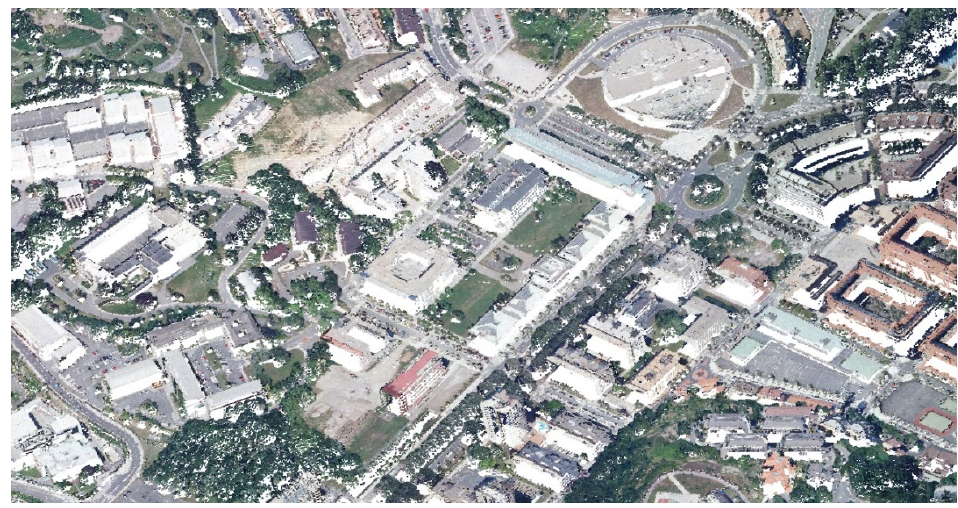
Figure 5. 2012 flight LiDAR point cloud of the UPV/EHU university campus in DSS. Cloud density: 1 point/m 2 .